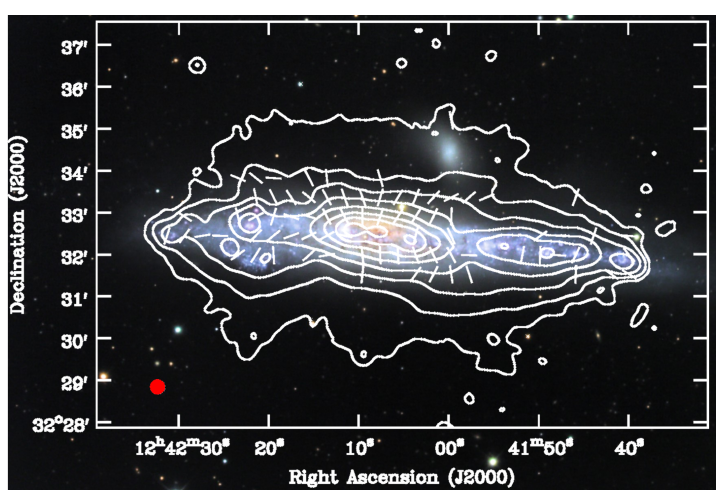
Figure 3. Radio continuum emission (contours) of the edge-on spiral galaxy NGC 4631 at 5.99 GHz from combined JVLA and 100-m Effelsberg observations with a resolution of 20.5 (cid:48)(cid:48) HPBW with intrinsic magnetic field orientation, overlaid on a color-scale optical DSS image [30].